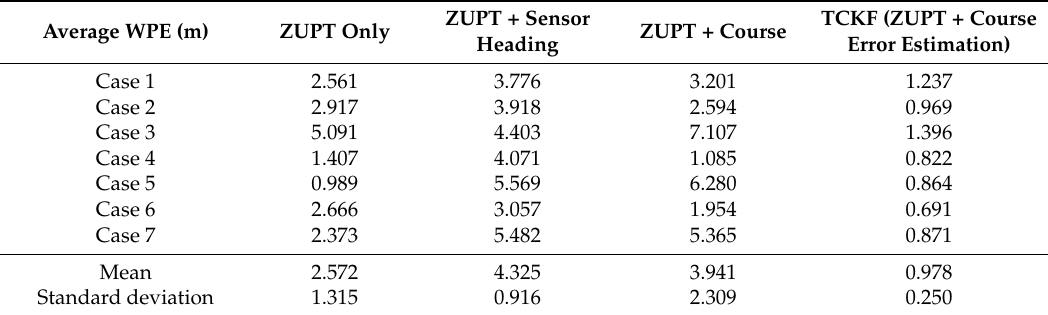
Table 3. Summary of experimental results (indoor